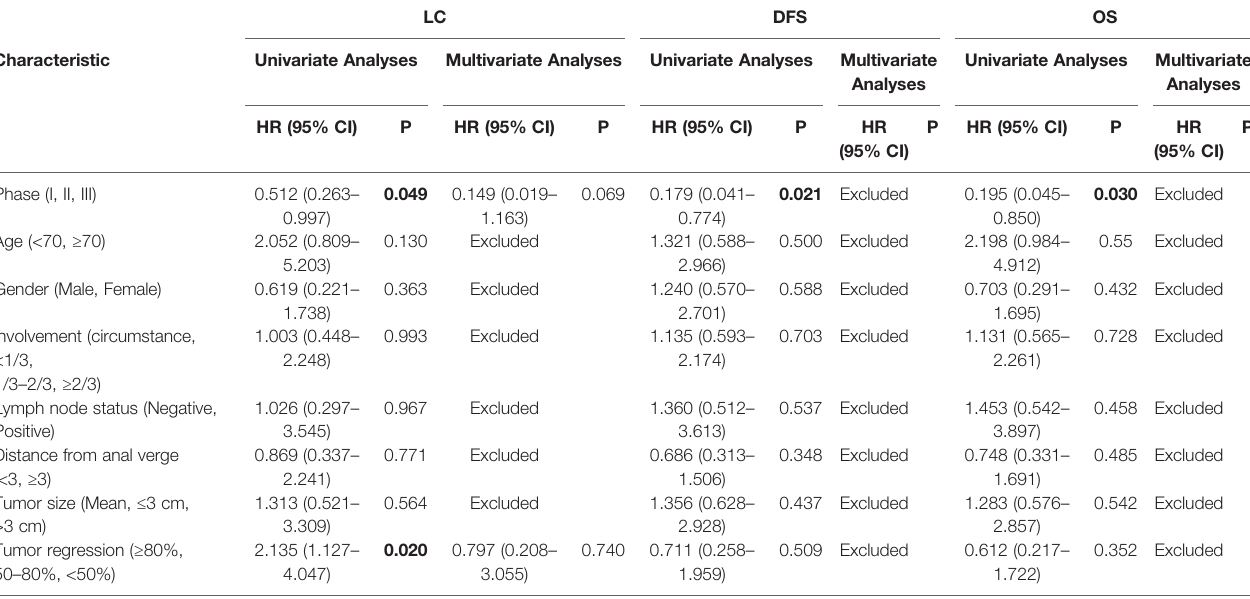
TABLE 3 | Univariate and multivariate analyses of factors associated with LC, DFS, and OS for T2 rectal cancer patients, respectively. LC DFS OS Characteristic